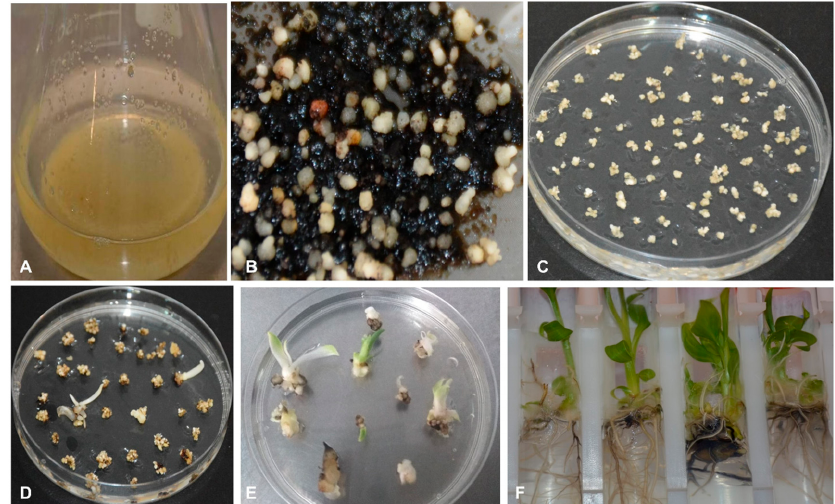
Figure 9. Transformation and regeneration of putative transgenic events of plantain cultivar Obino l’Ewai. ( A ) Cell suspension ready to be transformed; ( B ) Agro -infected cells showing the development